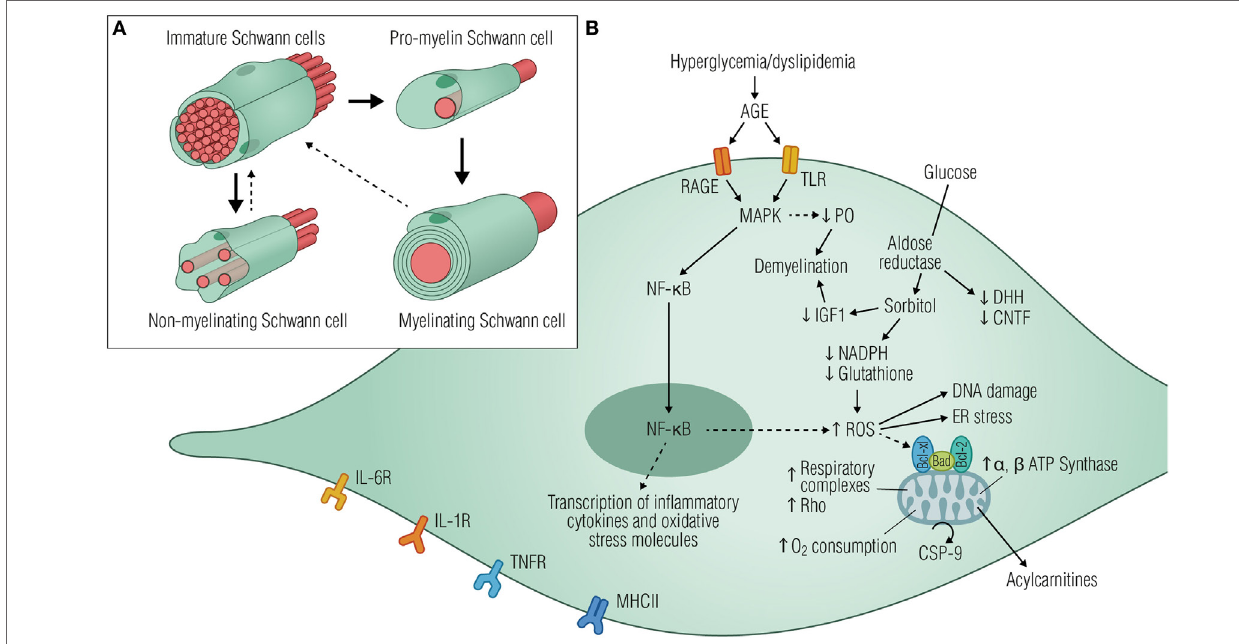
FiGURe 2 | Diabetic stressors lead to Schwann cell dysfunction and neurodegeneration. (A) Schematic illustration of the main developmental transitions of Schwann cells. Dashed arrows denote the reversibility of the final stage, where mature myelinating and non-myelinating cells might dedifferentiate as a result of injury or disease. (B) Elevated glucose levels are shunted into the polyol pathway by aldose reductase, depleting cytosolic NADH, and ultimately reducing regeneration of glutathione, an important cellular antioxidant. Consequently, glucose metabolism generates local oxidative damage, reduces the production of neurotrophic factors, activates the ER stress, and causes DNA damage, all of which drives the cells to an immature phenotype. Signs of mitochondrial stress triggered by hyperglycemia are also evident in Schwann cells by the increased expression of ATP synthase subunits and respiratory chain complexes I, III, IV, and V, thus increasing oxygen consumption and apoptotic signaling events. As a result, acylcarnitines are released from stressed Schwann cells, leading to axonal degeneration and fiber loss. AGE activation of RAGE and/or TLR induces downstream signaling events mediated, at least in part, by the activation of MAPK and NF- κ B with consequent transcription of inflammatory cytokines and oxidative stress molecules. Schwann cells have been recognized as immune-competent cells, expressing MHC class II molecules and several cytokine receptors such as IL-6R, IL-1R, and TNFR. Since MHC II antigen reactivity was detected in Schwann cells from patients suffering from diabetic neuropathy, it is plausible that these cells might be functioning as antigen processing and presenting cells contributing to immune responses within the peripheral nerves. Abbreviations: AGE, advanced glycation end products; RAGE, receptor for advanced glycation end products; TLRS, toll-like receptors; MAPK, mitogen-activated protein kinase; P0, protein 0; NF- κ B, nuclear factor κ B; NADPH, nicotinamide adenine dinucleotide phosphate-oxidase; IGF1, insulin-like growth factor 1; ROS, reactive oxygen species; ER, endoplasmic reticulum; CSP-9, caspase-9; IL-6R, interleukin-6 receptor; IL-1R, IL-1 receptor; TNFR, tumor necrosis factor receptor; MHCII, major histocompatibility complex